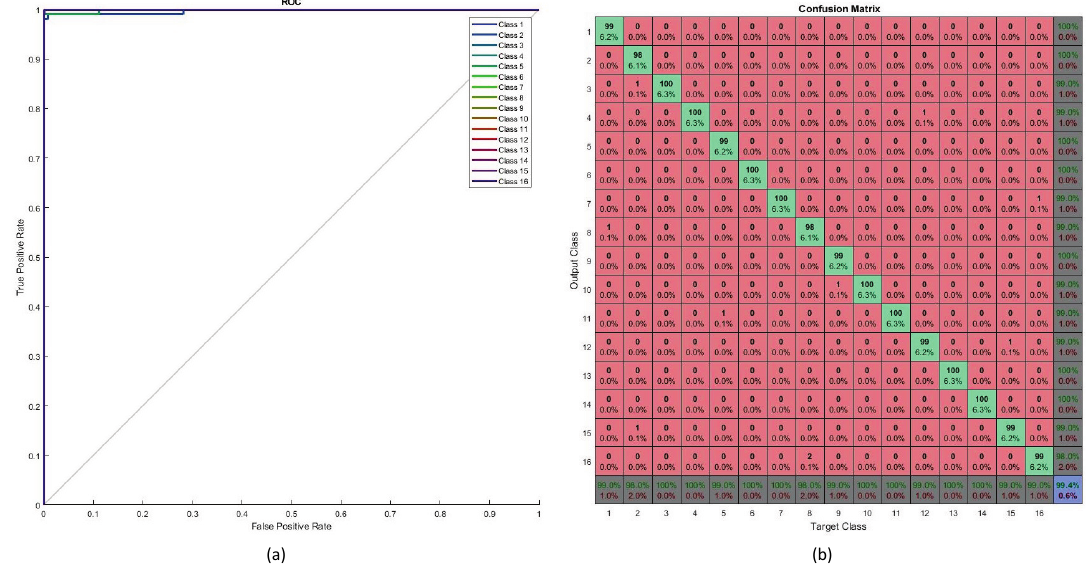
Figure 12. Testing performance, ( a ) testing ROC curve and ( b ) testing confusion